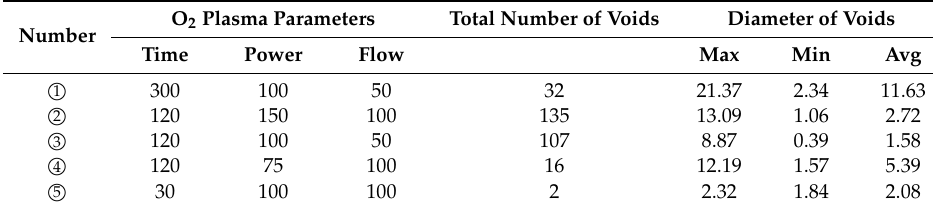
Table 3. Data analysis of void